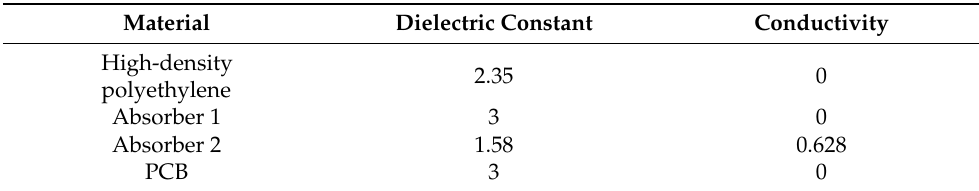
Figure 7. ( a ) Perspective view of the designed antenna model. ( b ) Cross-section of the designed antenna model. Table 2. Parameter values of the antenna model obtained after several simulations.